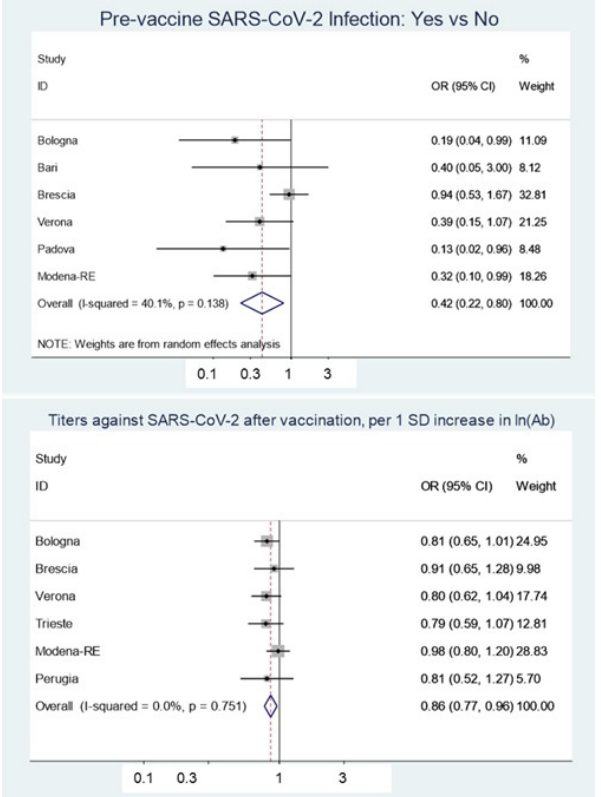
Figure 2. Forest plots evaluating the effect of SARS-CoV-2 infection before vaccination (upper panel) and antibody titers against SARS-CoV-2 after vaccination (lower panel) on the risk of breakthrough infection. A random-effect model was used for the former and a fixed-effects model for the latter. Odds ratio (OR) estimates for single centers are shown in boxes, and the pooled estimate is shown as a diamond. Error bars and values in parentheses indicate 95% confidence intervals.